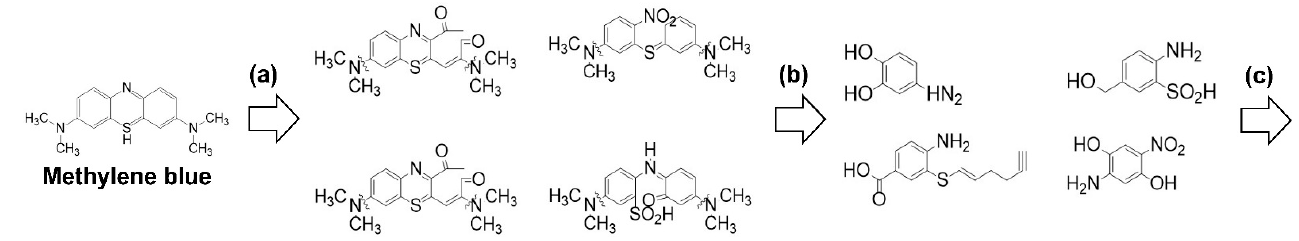
Figure 1. Illustration of degradation of methylene blue by reactive oxidizing species generated by a CP system [35,36]. ( a ) Generated radicals attack methylene blue. ( b ) Further oxidation of reaction intermediates. ( c ) Mineralization producing NO 3 − , SO 3 − , CO 2 , H 2 O, and so on.